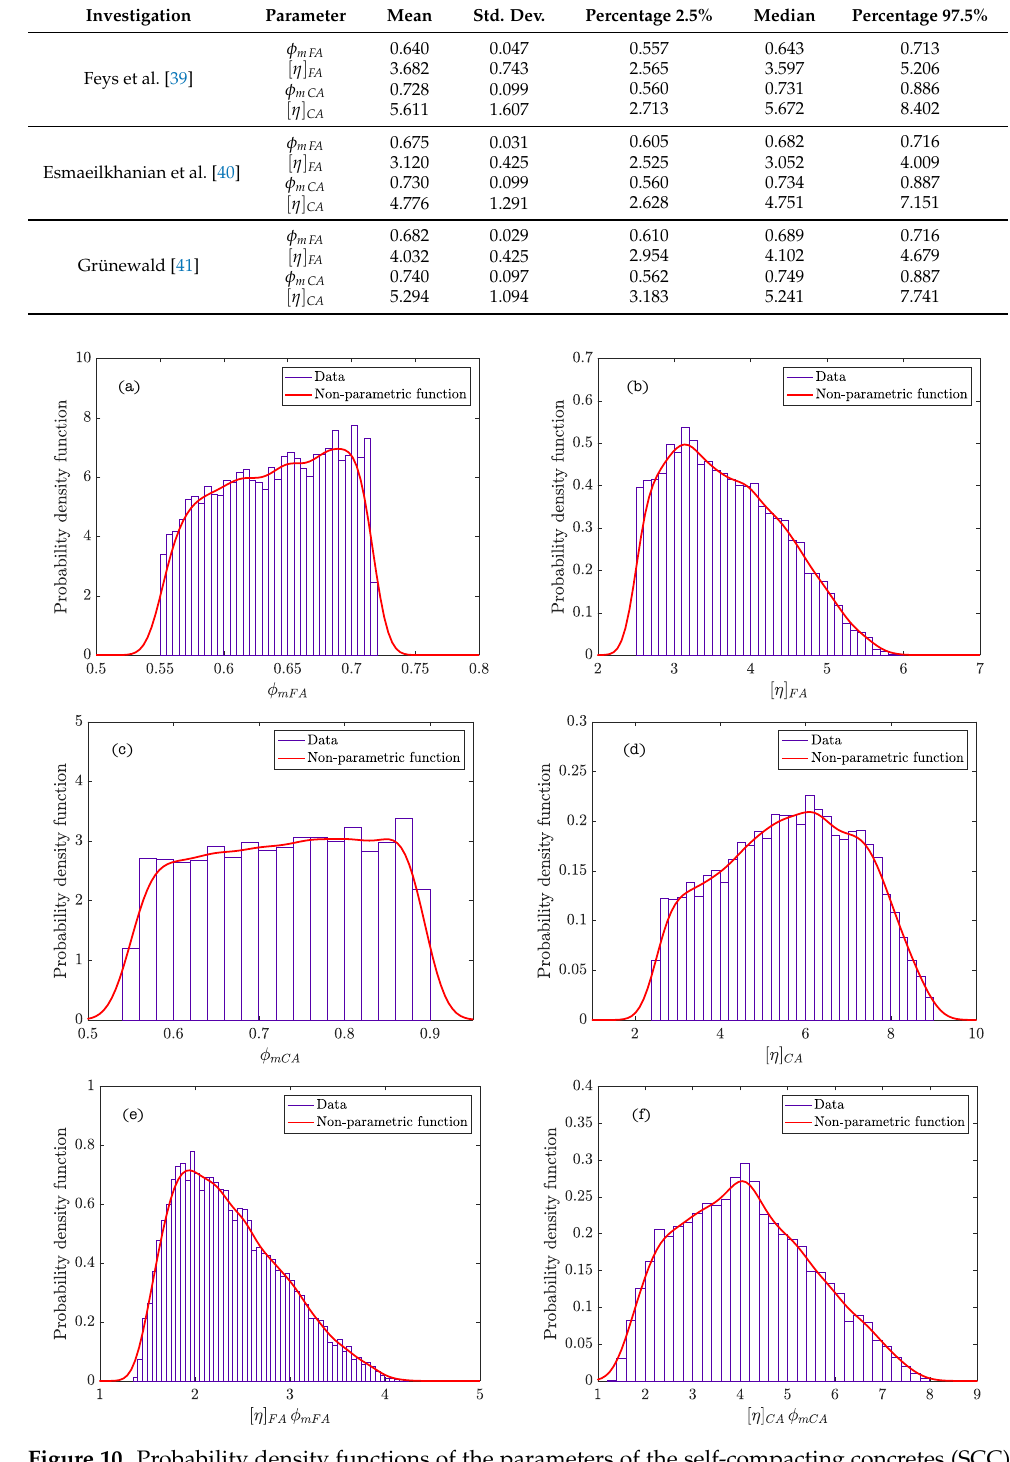
Figure 10. Probability density functions of the parameters of the self-compacting concretes (SCC) phases in Feys et al. [39]: ( a ) φ mFA ; ( b ) [ η ] FA ; ( c ) φ mCA ; ( d ) [ η ] CA ; ( e ) [ η ] FA φ mFA ; and ( f ) [ η ] CA φ mCA